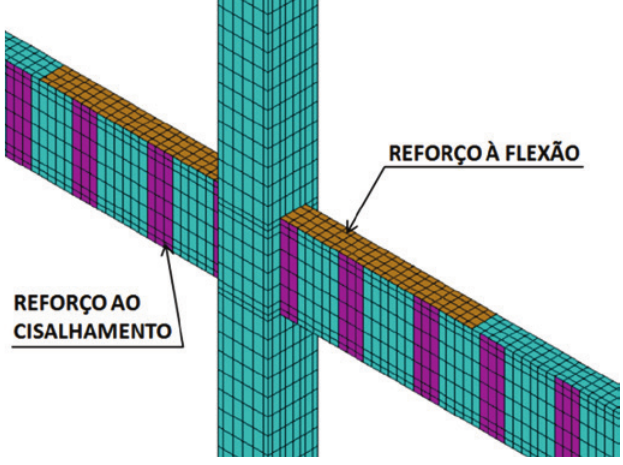
apresentadas neste trabalho.